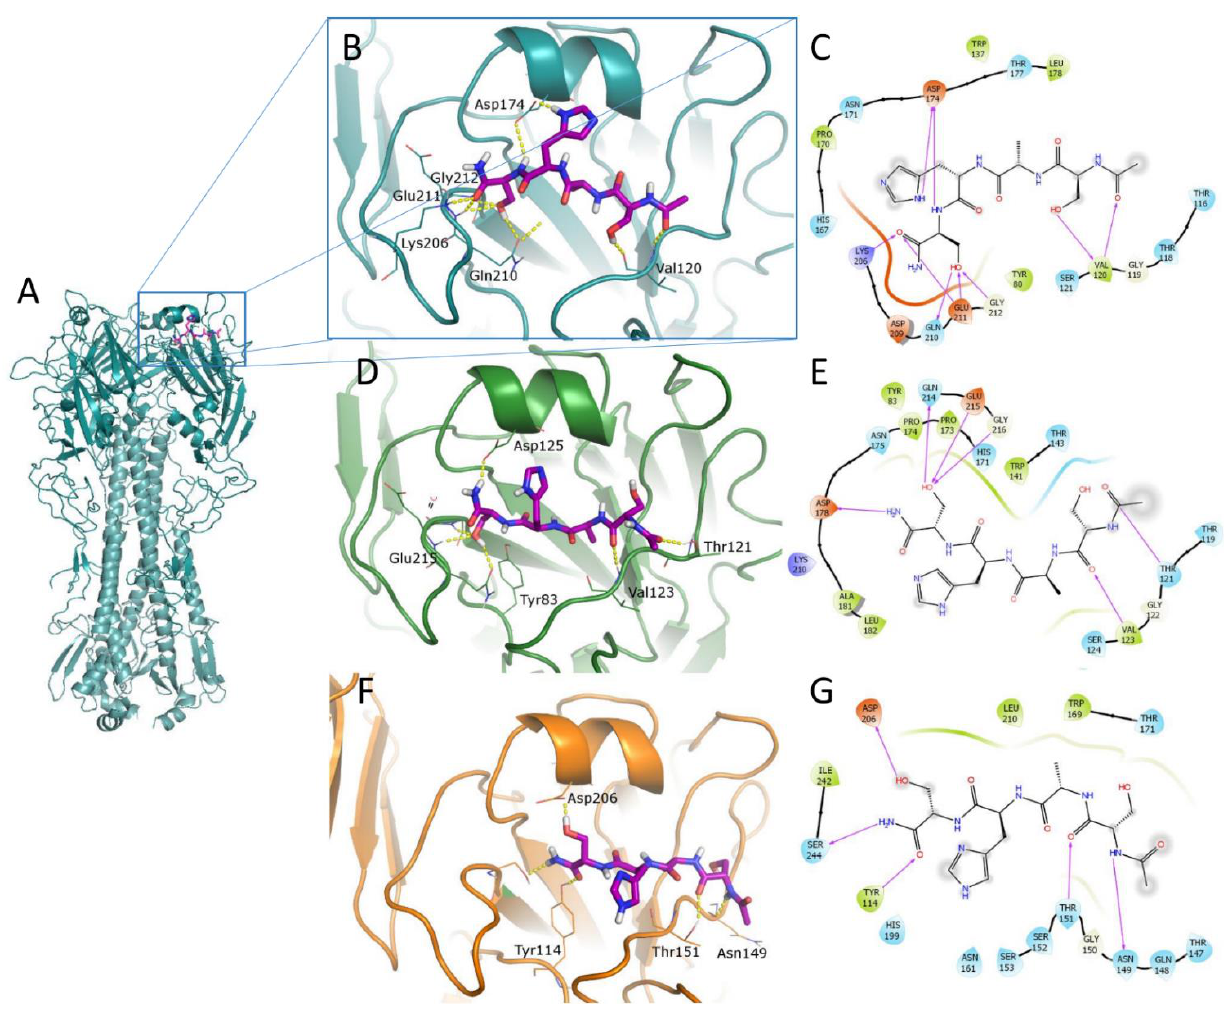
Figure 4. Docked poses of peptide 4 (purple C atoms, represented as sticks) in the RBS of studied HAs represented as cartoons. ( A ) Total view of Parma/H1N1 (deep-cyan HA1 chains, pale cyan HA2 chains); zoomed view of: ( B ) Parma/H1N1 (deep cyan); ( D ) Roma/H1N1 (dark green); ( F ) Parma/H3N2 (orange). Residues involved in H-bond interactions with the ligand are represented as lines; H-bonds are depicted as yellow dashed lines. Corresponding 2D ligand interaction diagrams are reported in panels ( C , E , G ); in these latter diagrams, residues close to the ligand are colored on the basis of their properties (orange, negatively charged; blue, positively charged; green, hydrophobic; cyan, polar), H-bonds are depicted as magenta arrows, solvent-exposed atoms are surrounded by a gray shadow.